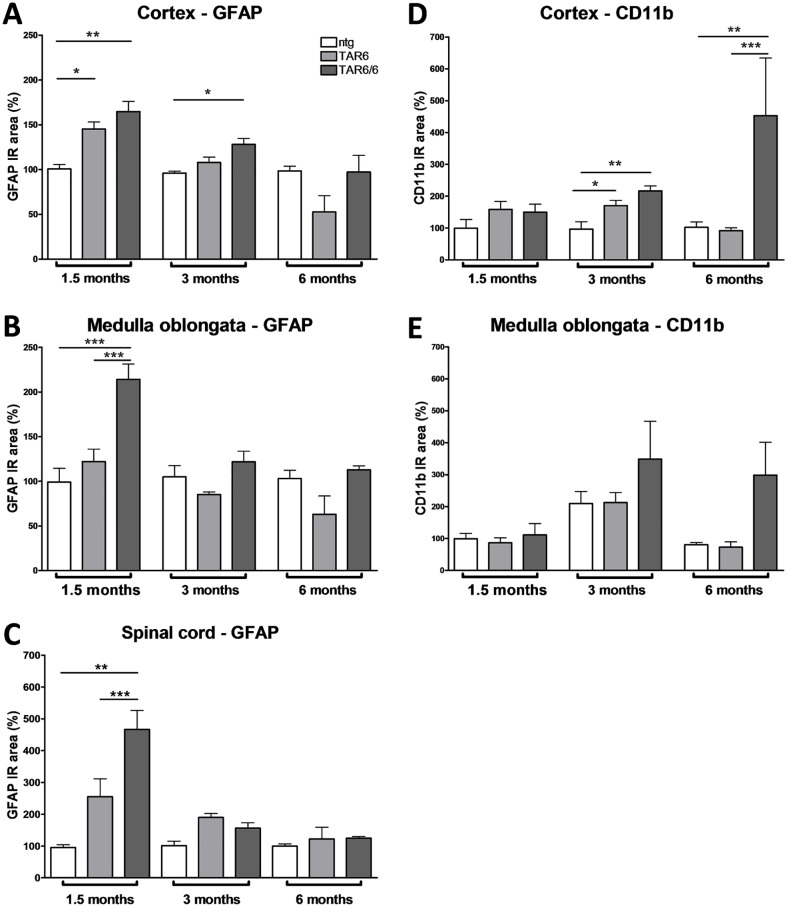
Quantification of GFAP and CD11b expression in the central nervous system of ntg, TAR6 and TAR6/6 mice.(A-C) GFAP expression levels labeling reactive astrocytes in the cortex (A), medulla oblongata (B) and spinal cord (C); and CD11b expression levels labeling reactive microglia in the cortex (D) and medulla oblongata (E) as IR area in percent. (A) 1.5 months: ntg: n = 4; TAR6: n = 9; TAR6/6: n = 5; 3 months: ntg: n = 4; TAR6: n = 9; TAR6/6: n = 5; 6 months: ntg: n = 3; TAR6: n = 3; TAR6/6: n = 3. (D) n as in A except: 1.5 months: TAR6: n = 10; 3 months: ntg: n = 5; TAR6: n = 8. (B, E) n as in D except: 3 months: TAR6/6: n = 7. C) n as in B except: 1.5 months: TAR6: n = 5; TAR6/6: n = 3; 3 months: ntg: n = 3; TAR6: n = 7; TAR6/6: n = 4. (A-E) Two-way ANOVA followed by Bonferroni‘s post-hoc test. Mean+SEM. *significances between genotypes. *p<0.05, **p<0.01, ***p<0.001.